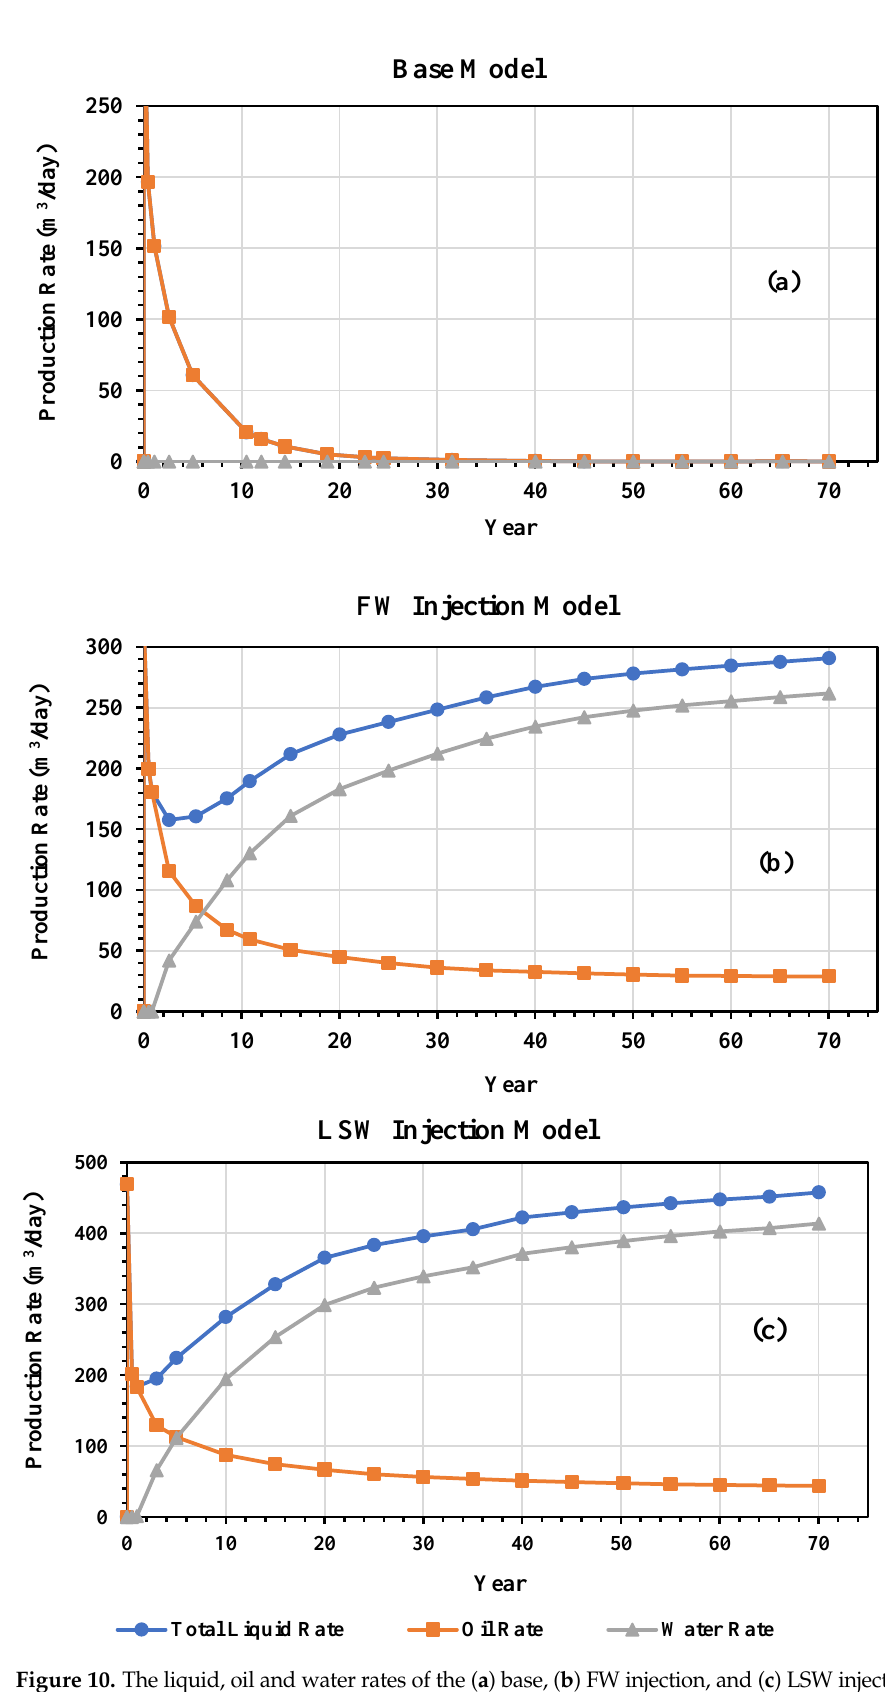
Figure 10. The liquid, oil and water rates of the ( a ) base, ( b ) FW injection, and ( c ) LSW injection models. As seen from Figures 8 and 9, the flow rate of produced oil expressively decreased over time, which is normal. With oil production, and the reduction in the pressure, the oil production capacity of the Kashkari oil field reduced and showed a downward trend. This decrease in oil production rate was greater in the FW injection model with a salinity of 3% than in the LSW injection model with a salinity of 0.1%, which indicates that the injection of water with low salinity is more effective in oil recovery of the Kashkari oil field. In the base model where the injection water was not implemented and was produced by natural pressure, the oil recovery rate was 1.3%. By injecting FW with a salinity of 3%, this amount of recovery increased by 3.2%, but when LSW with a salinity of 0.1% was injected into the oil field, oil recovery showed an increase of 5.1% compared with the base model. Based on Figures 8 – 10, the ionic changes in the injected water led to the activation of mechanisms for increasing the extraction of the aqueous base, including the change in wettability. In Figure 4, during the activation of the mentioned mechanism, the relative permeability curve of oil increased and the curve of water decreased, or in other words, the movement of water slowed and oil production increased. 4. Conclusions In this study, the recovery of the Kashkari oil field was evaluated by LSWF through a CMG-GEM simulation model. The process of oil recovery was first studied by a laboratory core flooding experiment to evaluate the efficiency of the LSWF method. Then, a laboratory test simulation model was designed to establish the possibility of applying the technique to the Kashkari oil field. In the last part of this study, the Kashkari oil field simulation model was designed and the LSWF method was applied to it. In the Kashkari oil field simulation model, three models (base, FW injection, and LSW injection) were considered for the evaluation of the effect of LSWF injection on oil recovery. The conclusions of this study are as follows: (1) The laboratory core flooding test showed that LSWF (with salinity 1%, 0.5% and 0.1%) can increase oil recovery up to a maximum of 8% after FW injection; (2) In CMG-GEM reservoir simulation software, it is possible to simulate intra-phase reactions, ion exchange, and dissolution/precipitation of minerals, and the behavior of ionic liquids can be observed; (3) The Kashkari oil field simulation model was established through CMG-GEM reservoir simulation software, and the LSWF (salinity 0.1%) oil recovery method was